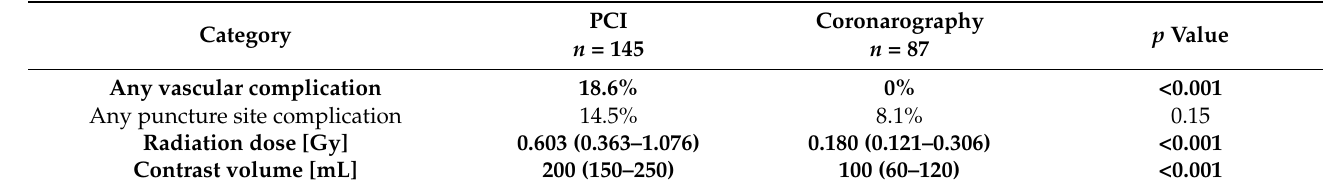
Table 2. Comparisons between PCI and